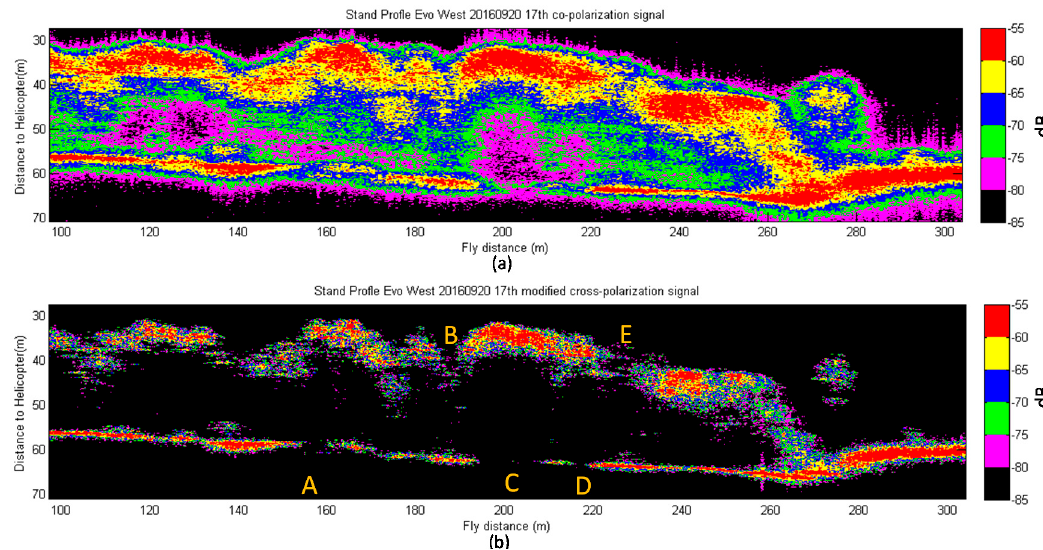
Figure 10 . Co- and cross-polarized returns of sample forest. Figure 10. Co- and cross-polarized returns of sample